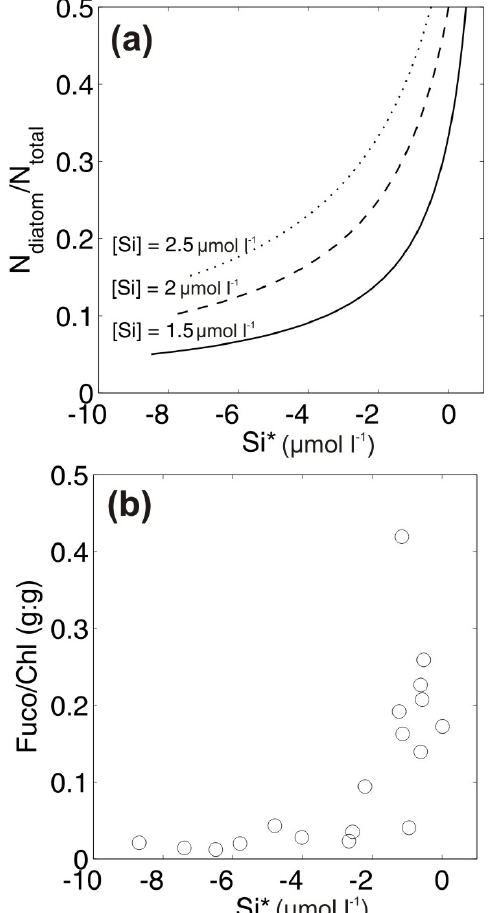
Fig. 5. Theoretical calculation of the fractional contribution of diatoms to overall community biomass (as indicated by diatom over total phytoplankton nitrogen, N diatom /N total ) as a function of Si ∗ (µmoll − 1 ) within a hypothetical supply water at 3 set silicate concentrations representative of waters from around 300m in the NASG (a) . The relationship between observed Si ∗ (µmoll − 1 ) at 300m and the fucoxanthin:chlorophyll ratio (white dots) (b) , an in- dex of the fractional contribution of diatoms to community biomass observed at the DCM within cyclonic and MWE sampled in the NASG as part of the EDDIES